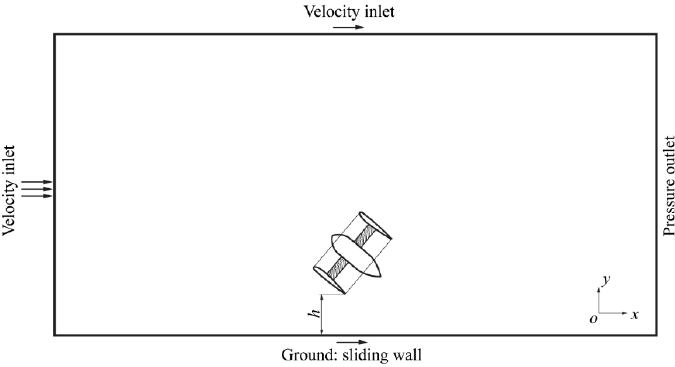
Figure 21. Boundary conditions when transitioning in ground